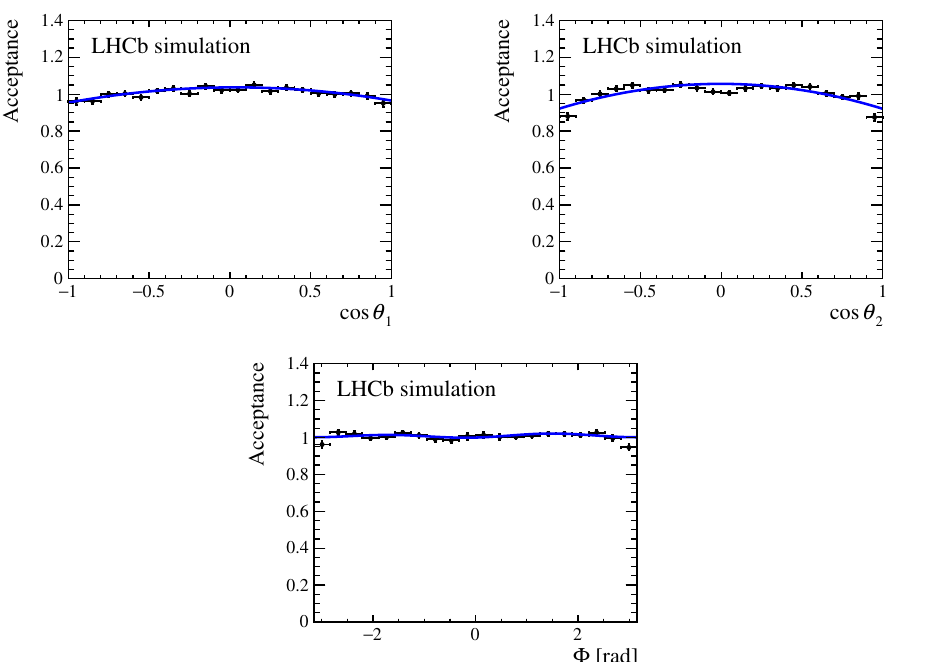
Figure 3 . Angular acceptance normalised to the average obtained using simulated B 0 (top-left) integrated over cos (cid:18) 2 and (cid:8) as a function of cos (cid:18) 1 , (top-right) integrated over cos (cid:18) 1 and (cid:8) as a function of cos (cid:18) 2 , and (bottom) integrated over cos (cid:18) 1 and cos (cid:18) 2 as a function of (cid:8). Each (cid:12)gure includes the resulting (cid:12)t